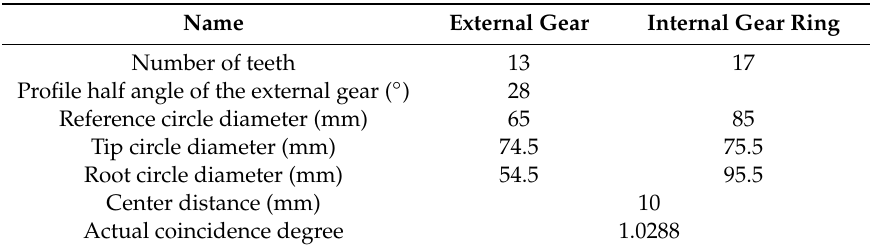
Table 1. Geometric parameters of the gear